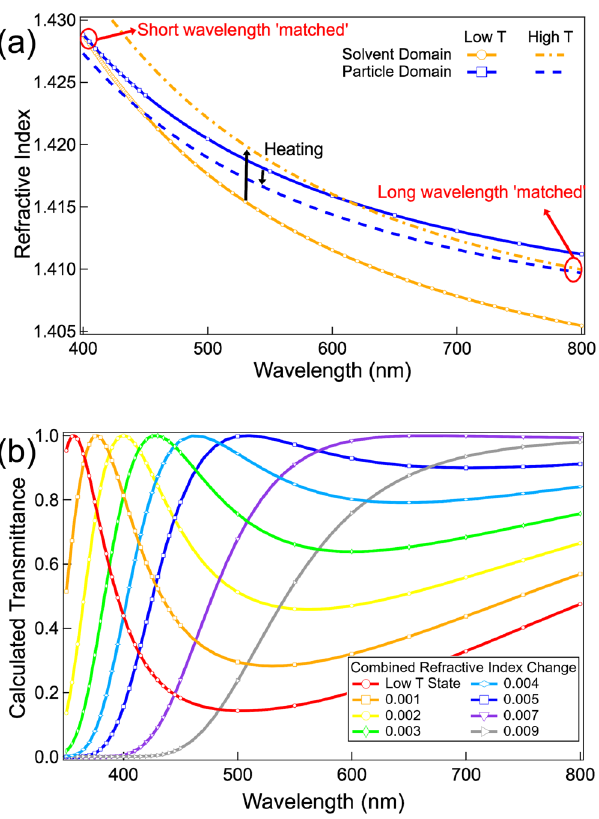
Supplementary Fig. 13. As SeedGels can be prepared by different